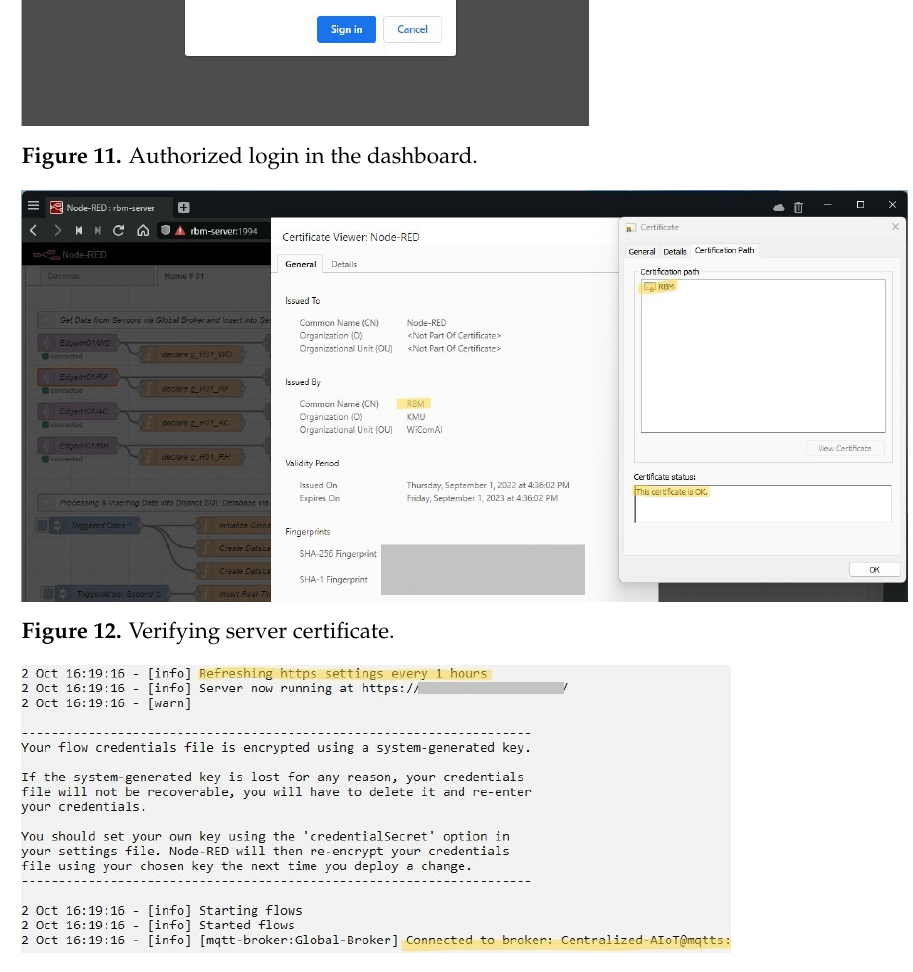
Figure 13. Establishing MQTT secure connection with Node-RED